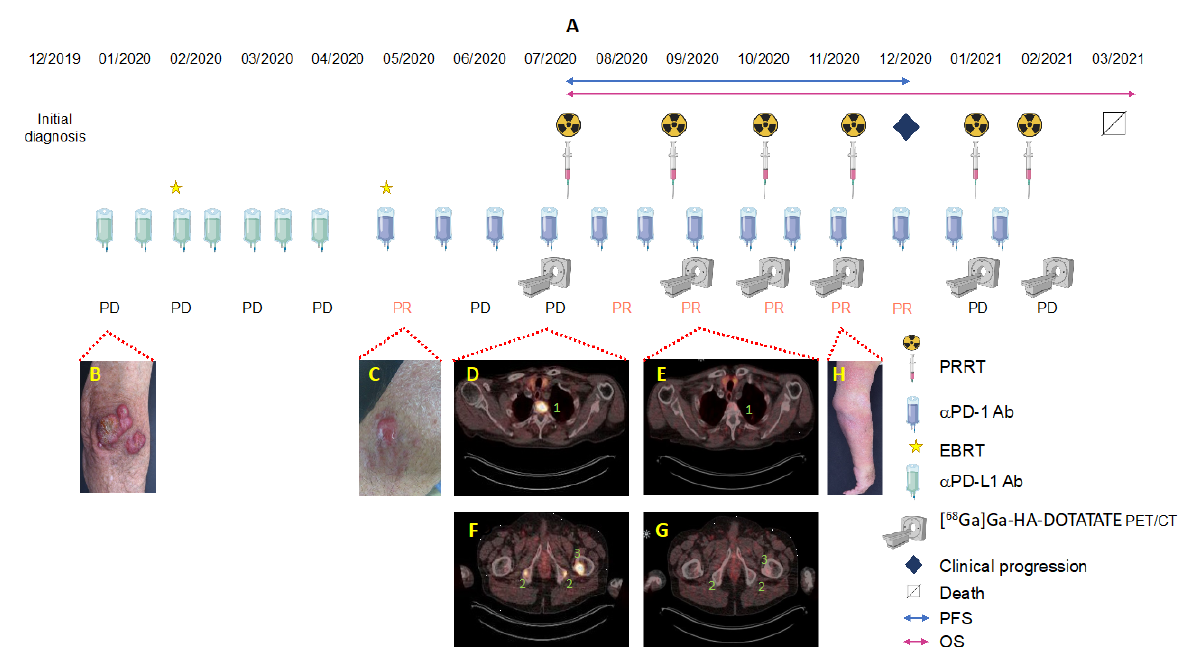
Figure 2. Schematic of the treatment regimen of patient A. ( A ) Clinical course of patient A including photographs of MCC lesions ( B , C , H ) and fused axial [ 68 Ga]Ga-HA-DOTATATE-PET/CT scans ( D , F ) before and ( E , G ) after 2nd SILD-PRRT with concomitant pembrolizumab. Pathologic foci of enhanced uptake of the radiotracer are indicated by numbers: T2 thoracic vertebral body (1), bone metastases located at the ischial tuberosities (2; both sides), and femur (3; left).